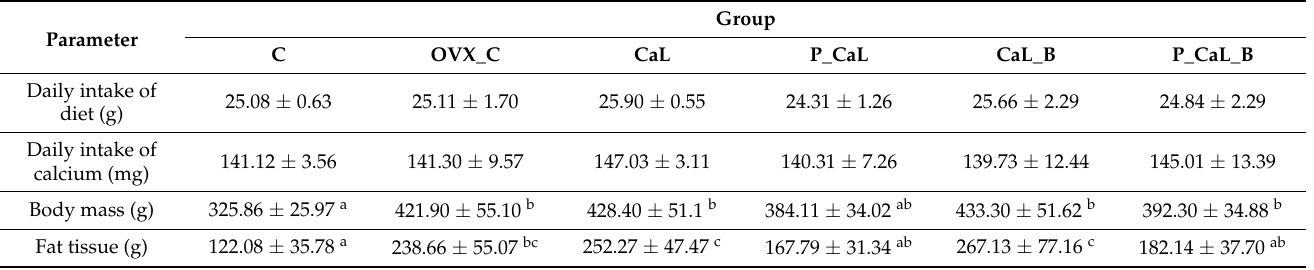
Table 2. Daily intake and parameters of the body composition analysis in rats (mean and standard deviation).